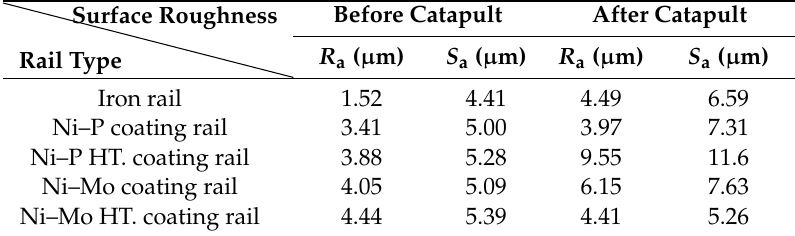
Table 4. The surface roughness of various